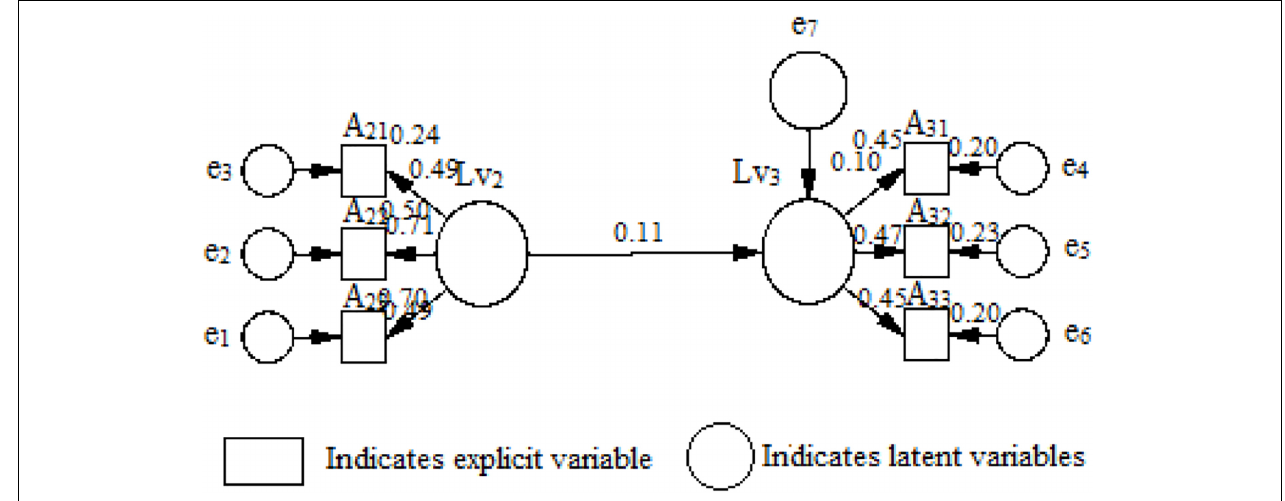
FIGURE 2 | Structural equation model of the impact of renewable energy development on regional economic